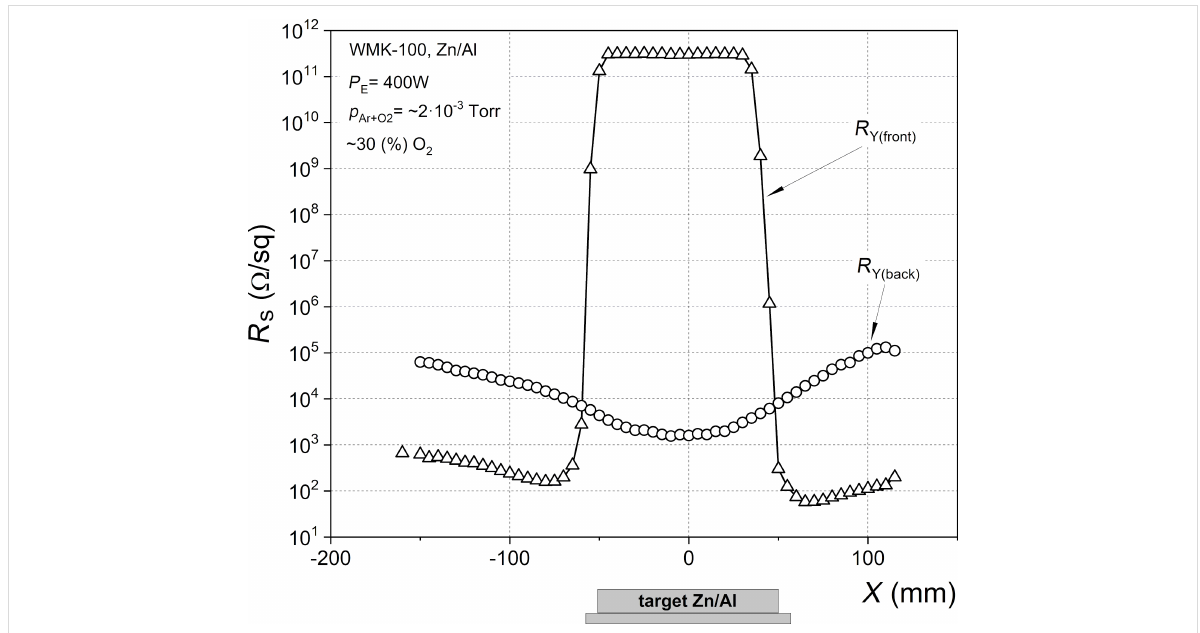
Figure 4: Surface resistance measured for the thin film deposited on both sides of the glass substrate as a function of the distance X from the Zn/Al target axis. The line is to guide the eye.